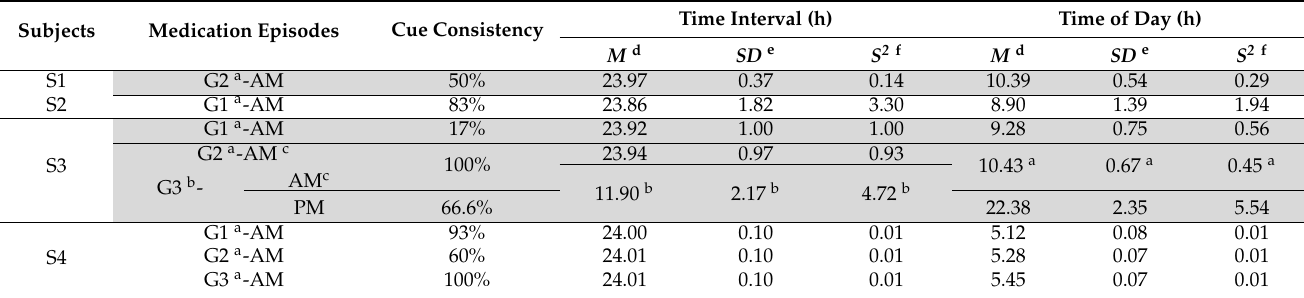
Table 2. Results of the consistency measures.